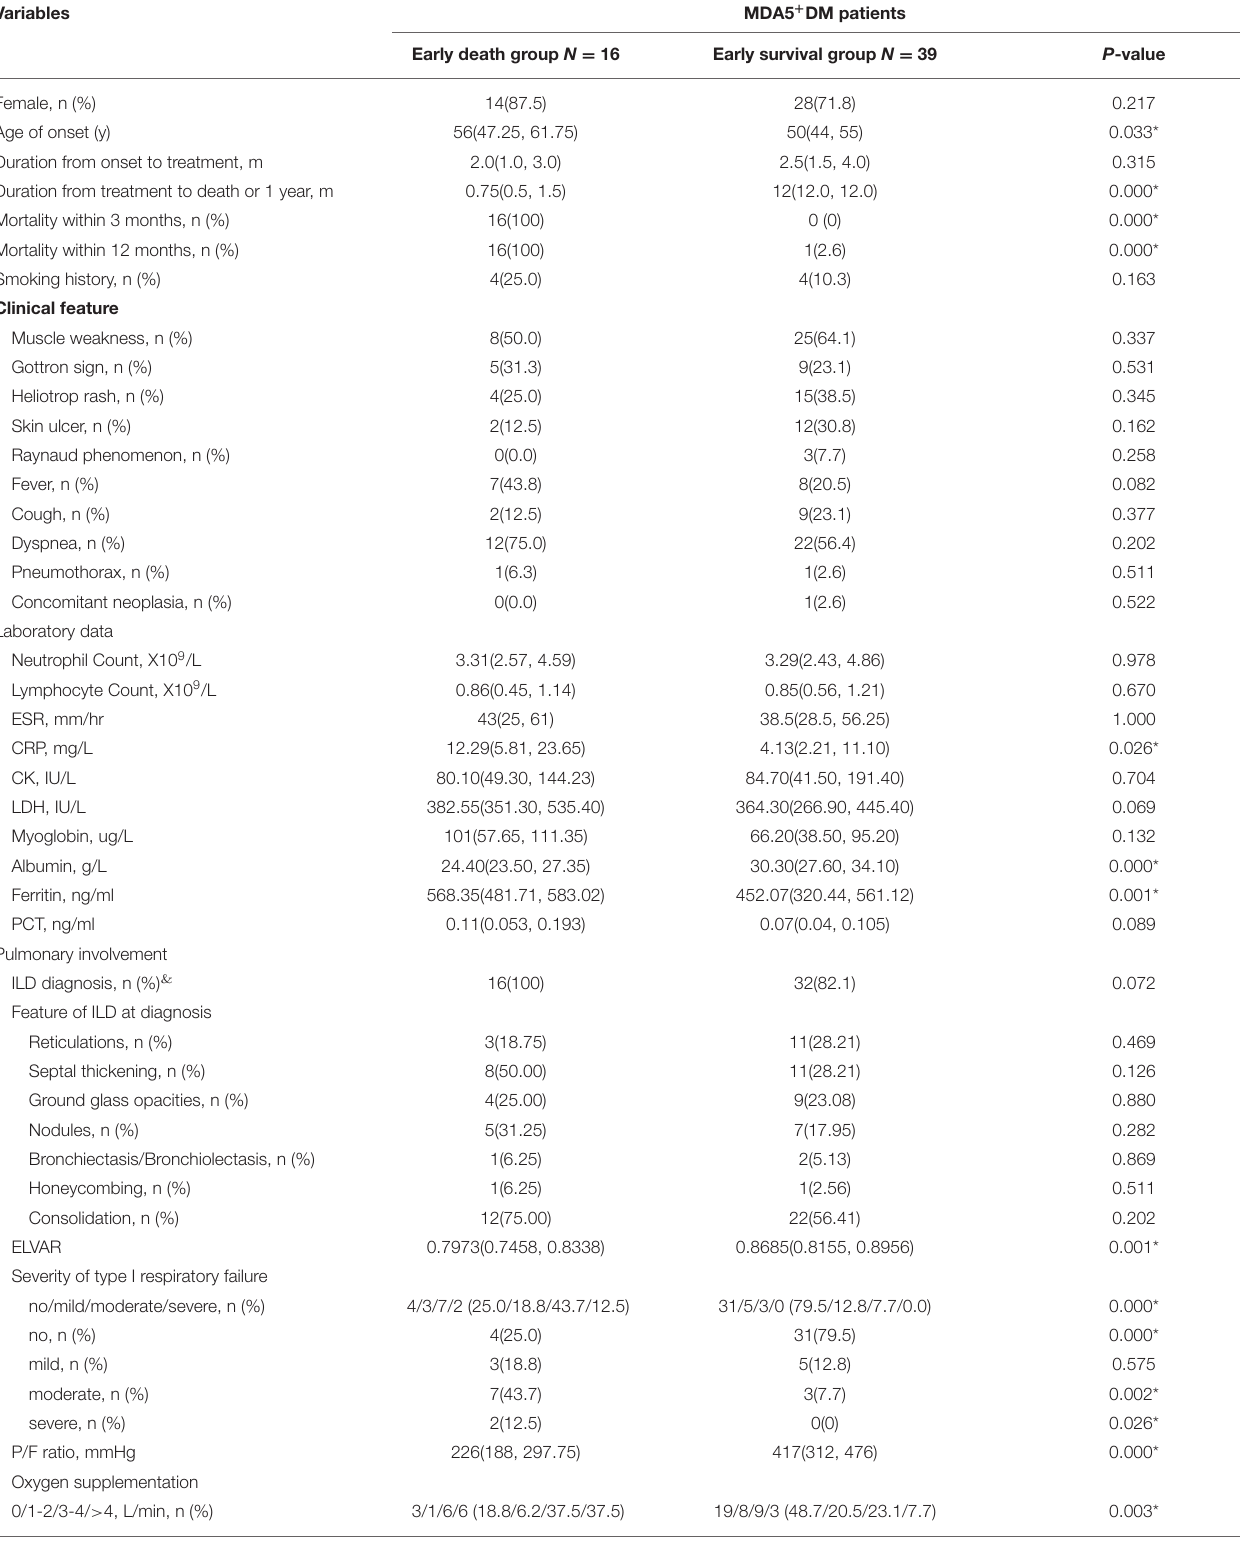
TABLE 1 | Comparison between early death group and early survival group in MDA5 + DM.